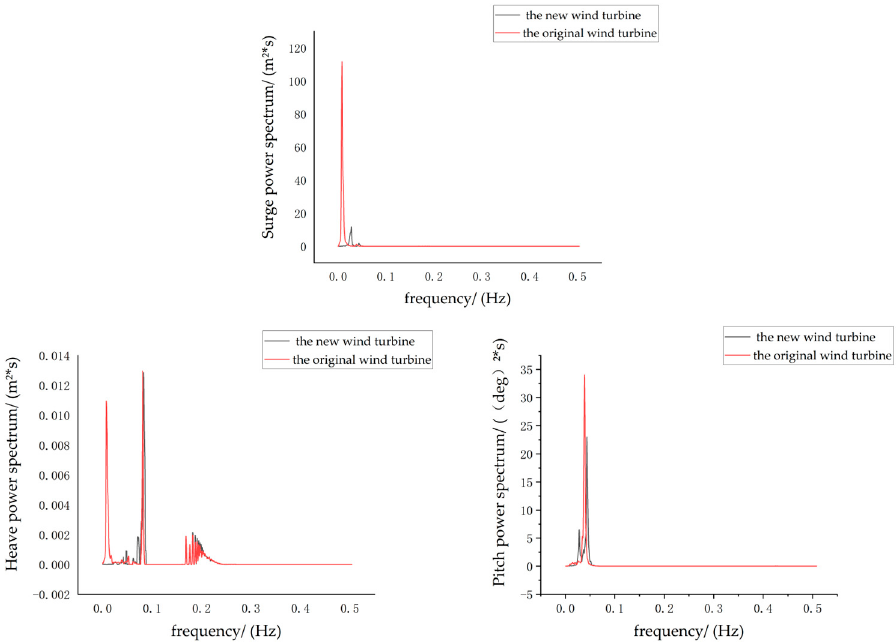
Figure 6. Comparison of platform movement in frequency domain under normal operating condi- tion.